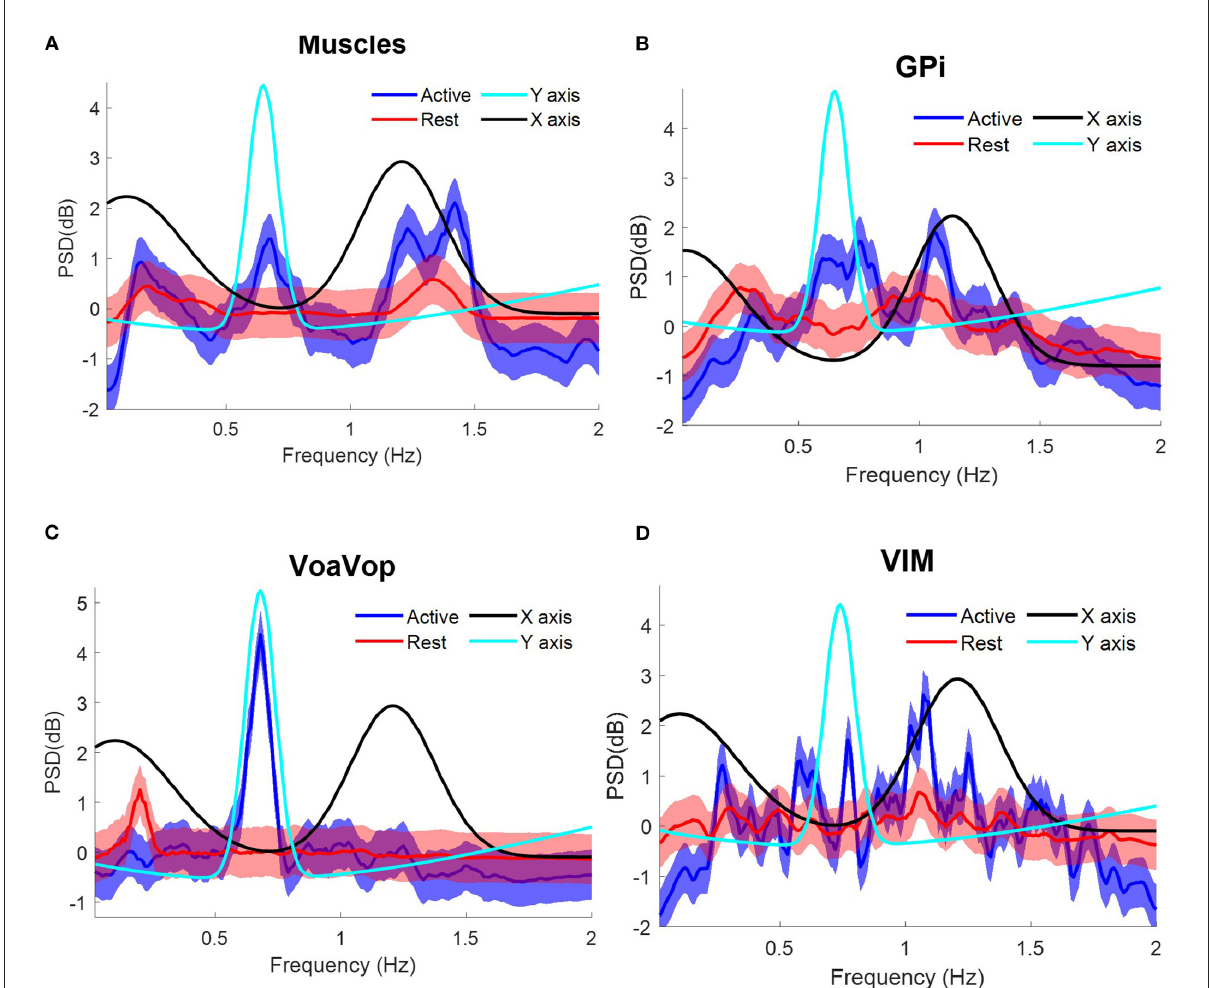
FIGURE5 Task frequency components for the patient with Tourette syndrome. Contralateral muscles and brain signals during the figure-eight drawing task, recorded from multiple surface EMGs and from multiple externalized DBS electrodes. Power spectrum density (PSD) for kinematic data is shown for comparison: f y component (cyan) and f x component (black). Grand average and standard deviation across all muscles and all microwire electrode recordings during all repetitions of the figure-eight drawing (blue) and resting (red) conditions. (A) Grand average across contralateral muscles. Grand average of left-side brain targets. (B) Brain signals from globus pallidus interna (GPi). (C) ventral oralis anterior/posterior (VoaVop), (D) ventral intermediate (Vim). Vertical axis: power spectra (dB). Horizontal axis: frequency